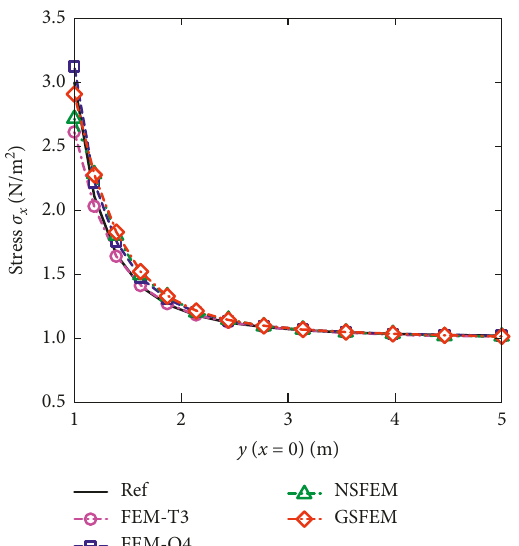
Figure 17: Stress along the left boundary ( x